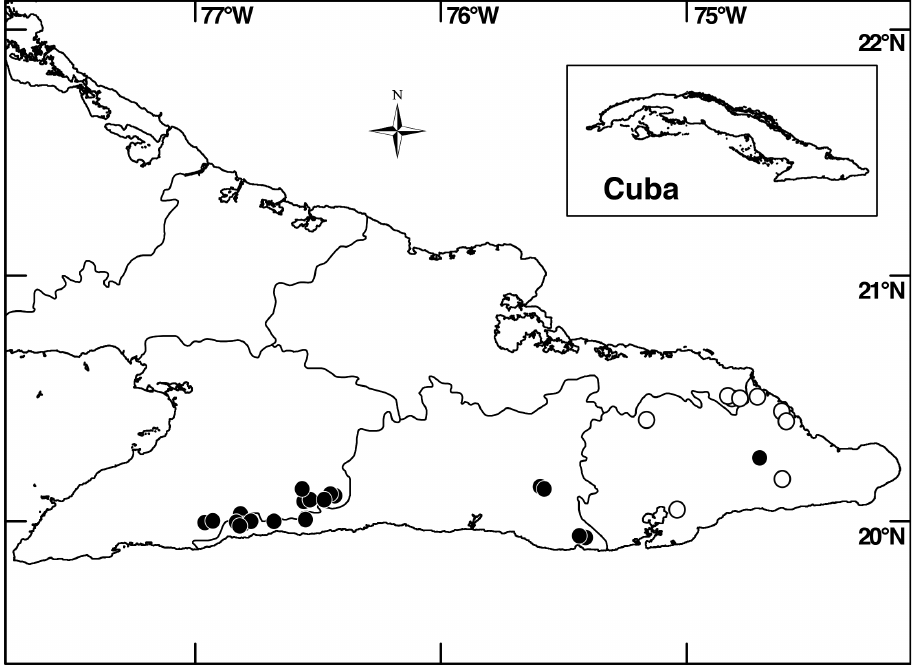
Figure 8. Distribution of Miconia norlindii (closed circles) and M. granulata (open circles). hairs forming crown, placentation axile with deeply intruded placenta, 3–4 locular; berries globose, 4-lobed to unlobed, purple at maturity, 3.1–4 mm long (including calyx tube), 3.4–4 mm wide, seeds 0.6–0.7 mm long, obpyramidal, testa smooth, light brown, raphe dark brown, smooth, extending the length of the